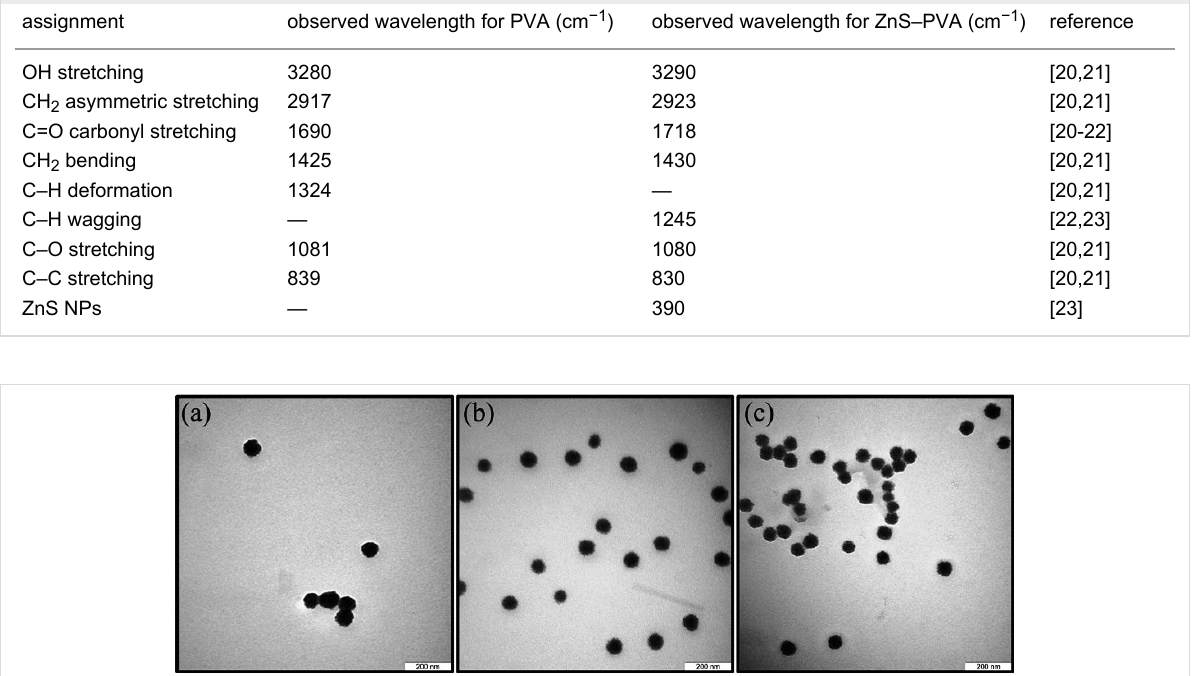
Table 1: The FTIR results of PVA and ZnS–PVA nanofluid.